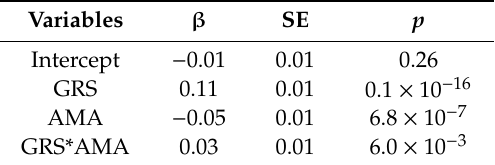
Table 4. Linear model results. Estimates (β) and p ‐values ( p ) for the effects of genetic risk score (GRS) and Amerindian ancestry (AMA) on body mass index z-score in Mexican schoolchildren.